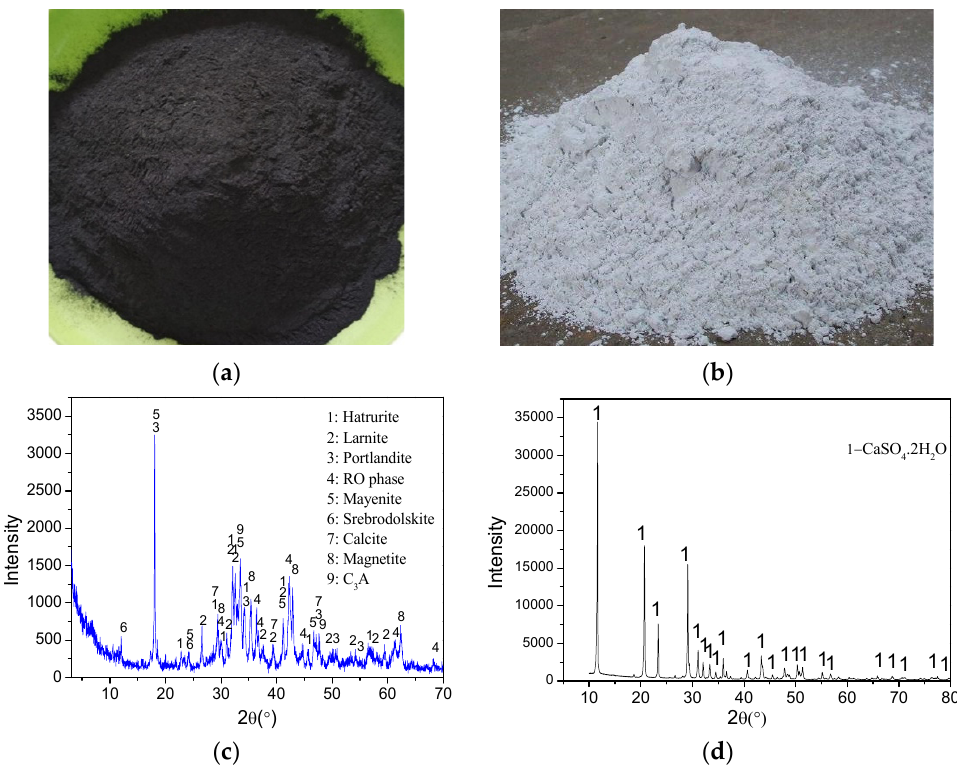
Figure 2. Images of SS ( a ) and DG ( b ) used in the study, and X ‐ ray diffraction patterns for the SS ( c ) and DG ( d ).